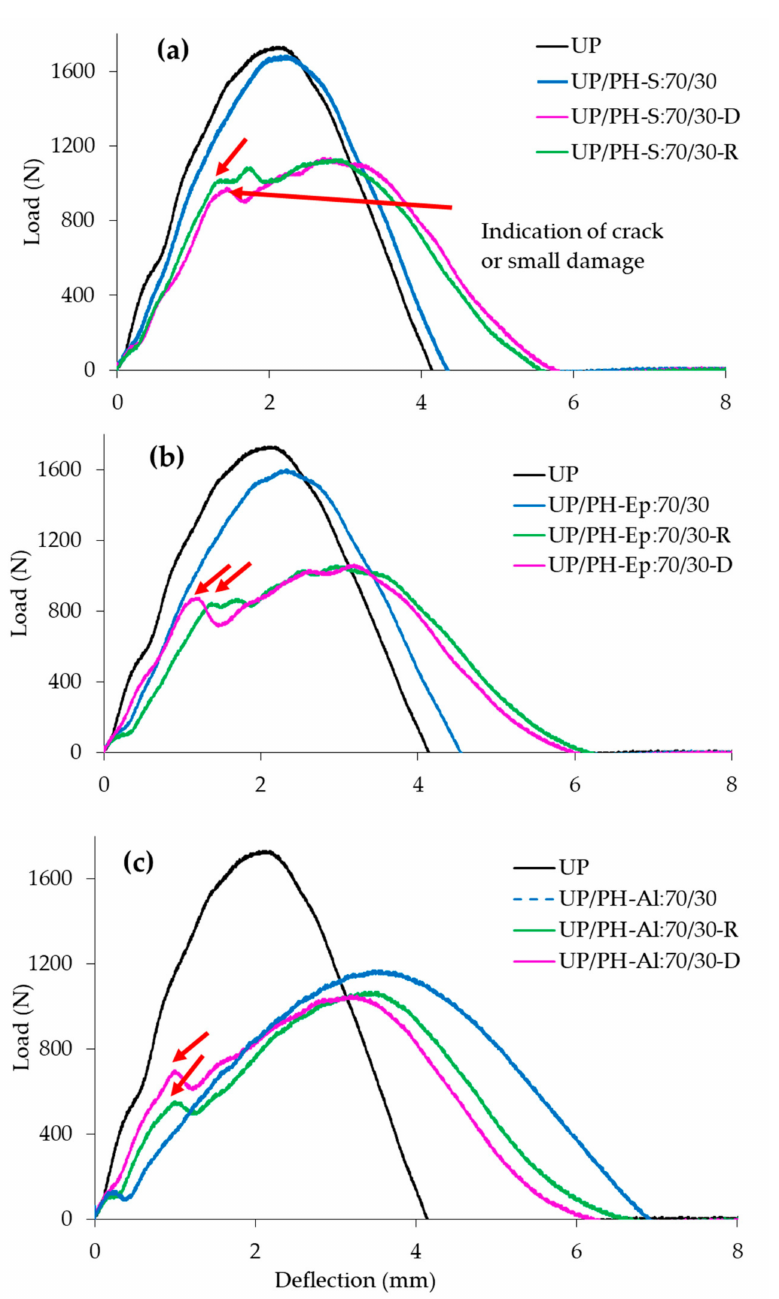
Figure 7. Load vs. deflection curves of GFRC of UP and ( a ) UP/PH-S, ( b ) UP/PH-Ep and ( c ) UP/PH- Al with FRs from drop-weight impact